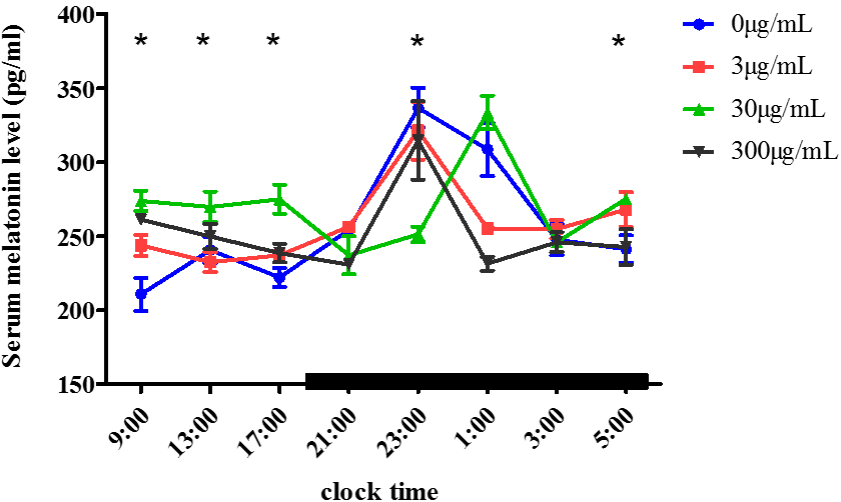
Figure 1. Serum melatonin levels in mice after oral melatonin. The mice were treated with different concentrations of melatonin (0 µ g/mL, 3 µ g/mL, 30 µ g/mL, 300 µ g/mL) in their drinking water for 3 weeks, then the serum melatonin was measured by ELISA at different time points (mean ± SD, n = 3). Bars indicate scotophase duration. “*” indicates that there was a significant difference ( p < 0.05) between the 30 µ g/mL melatonin-treated group and the control group at different time points.